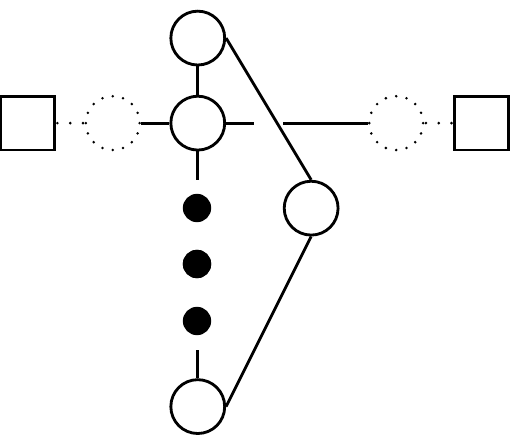
Figure 11. Typical quiver diagram for b A k (cid:0) 1 theory. To have a nontrivial cycle, the closed quiver should be on the genus one cycle, or the M5-branes should be aligned along the corresponding non-contractable circle. As long as a pair of E-strings is formed, we can attach it to any node. We can decouple such E-strings in a local limit to have six-dimensional N = (2 ; 0) SCFT of b A k (cid:0) 1 type that is free of gauge